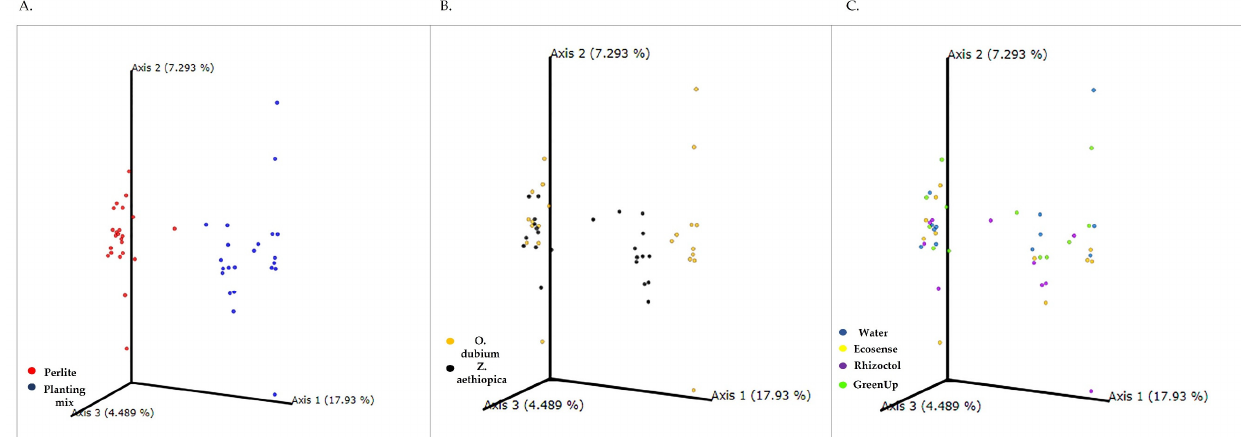
Figure 4. Principal-coordinates analysis (PCoA) plots of unweighted Unifrac distance metrics of bacterial populations in the root-associated environment of Ornithogalum dubium and Zantedeschia aethiopica based on data from two growing seasons. ( A ) PCoA plot of data for the two growing media: perlite (red) and planting mix (blue). ( B ) PCoA plot of data by plant species: O. dubium (orange) and Z. aethiopica (black). ( C ) PCoA plot of data by growth-promoter treatment: water (control; blue), Ecosense (yellow), Rhizoctol (purple) and GreenUp (green). Each data point represents sequences from a single soil sample; the plot contains all of the samples collected during two growing